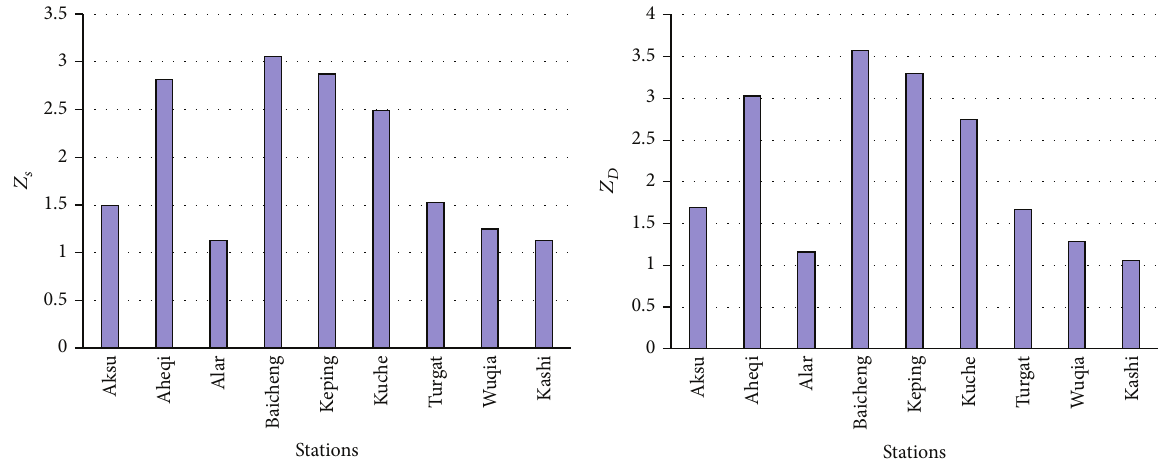
Figure 9: Mann–Kendall test ( 𝑍 𝑆 ) and Spearman’s Rho test ( 𝑍 𝐷 ) for the SPI-12